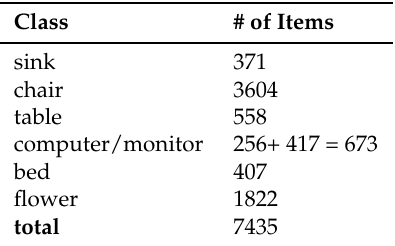
Table 1. Dataset statistics.